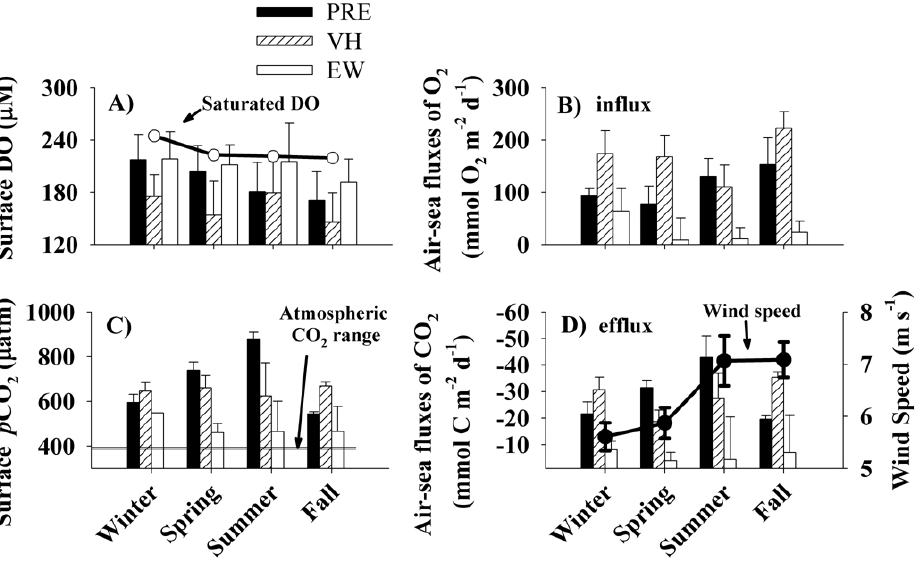
Fig. 4. Seasonal variations in (A) surface DO, (B) air-sea fluxes of O 2 , (C) surface p CO 2 and (D) air-sea fluxes of CO 2 near the Pearl River estuary (PRE), Victoria Harbor (VH) and eastern coastal/shelf waters (EW) during 2005 and 2006. Error bars =± 1SD and n = 4 to 12. The saturated DO, wind speed and a range of atmospheric p CO 2 levels (349 to 460µatm) are indicated.